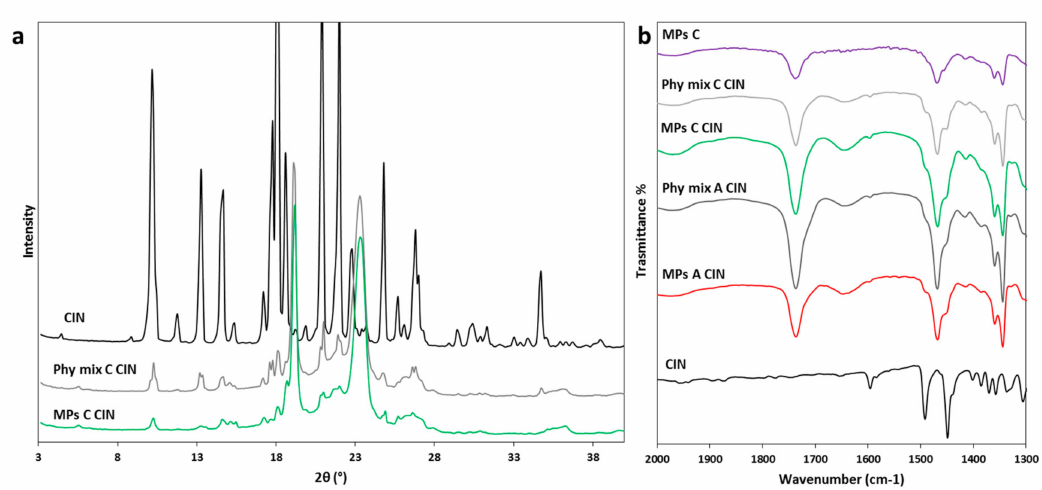
Figure 9. ( a ) XRPD spectra of CIN, Phy mix C CIN and MPs C CIN; ( b ) FT-IR spectra of CIN, MPs A